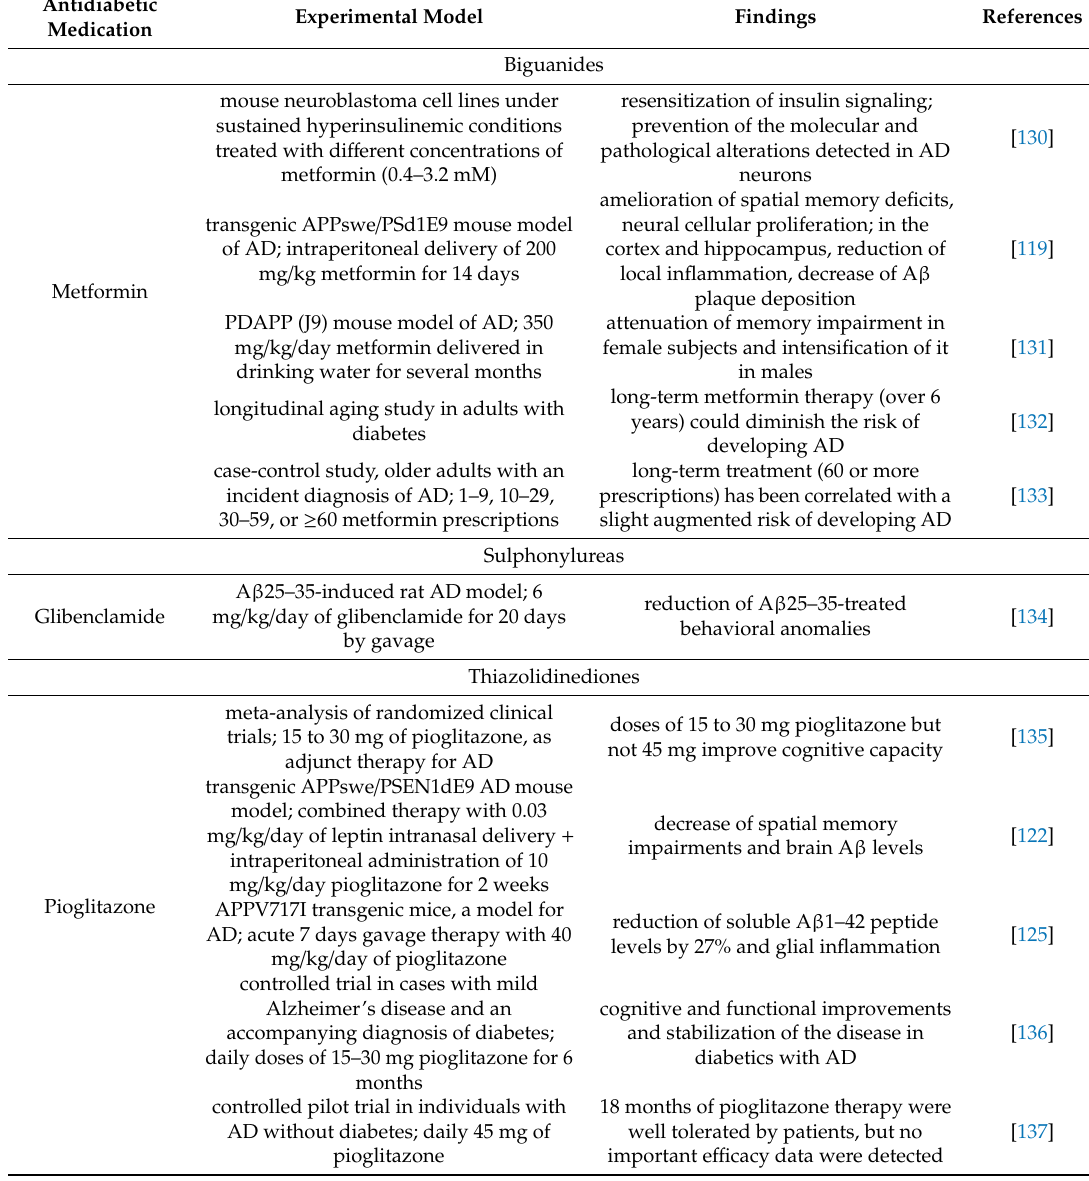
Table 2. Comparative e ffi ciency and acceptability of antidiabetic compounds for Alzheimer’s disease. Antidiabetic Experimental Medication